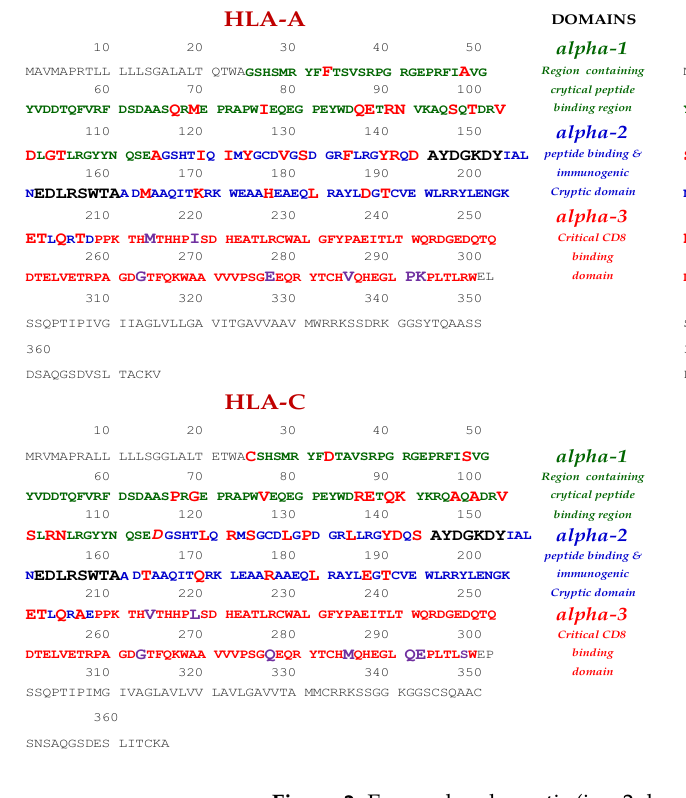
Figure 2. Exposed and cryptic (in α 2 domain) amino acid sequences of classical HLA-I (HLA-Ia) on the cell-surface.